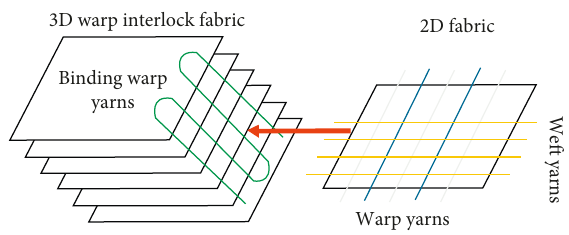
Figure 1: Geometric view of multilayer woven structures linked into the thickness by binding warp yarn.